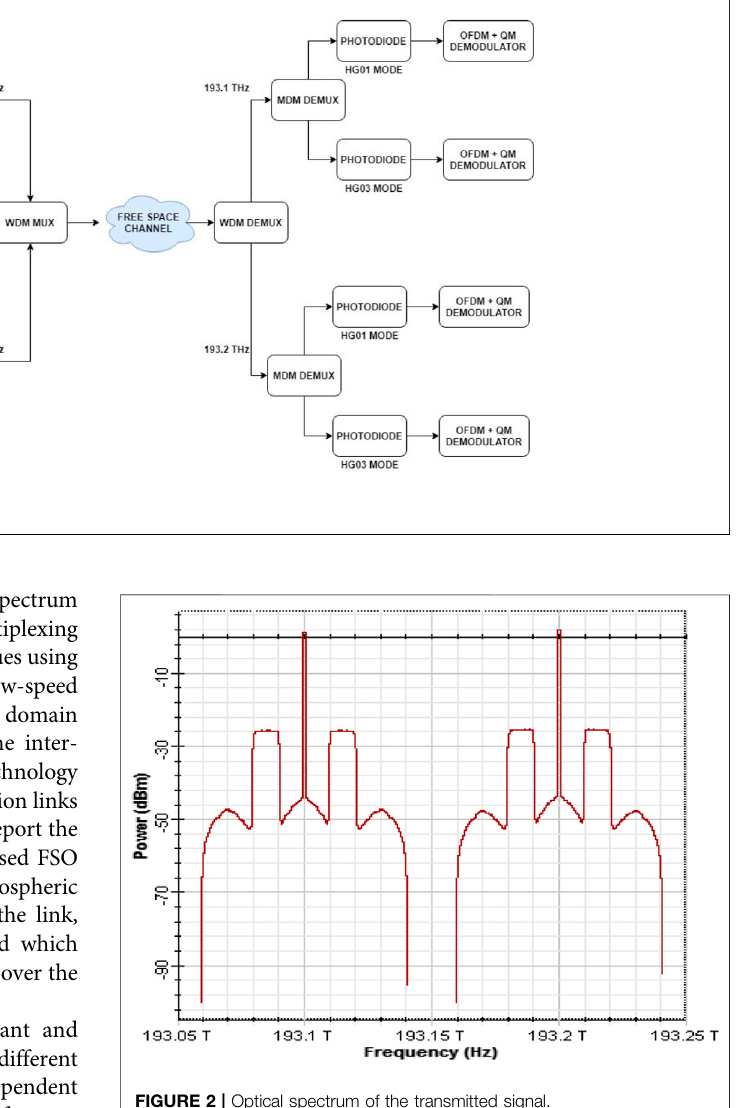
FIGURE 2 | Optical spectrum of the transmitted